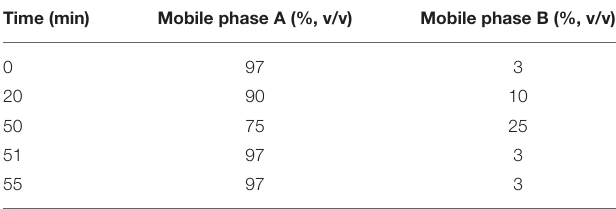
TABLE 1 | Gradient elution program for separatory HPLC.